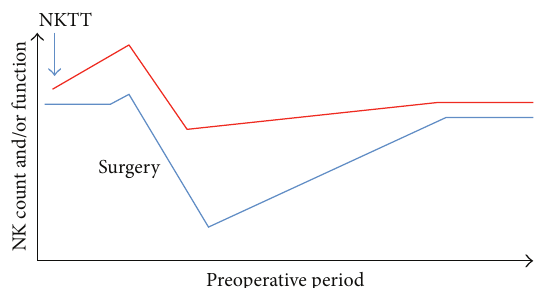
Figure 3: Expected changes in natural killer (NK) cell function and count after the preoperative or “preventive” infusion of expanded allogeneic or autologous NK cells